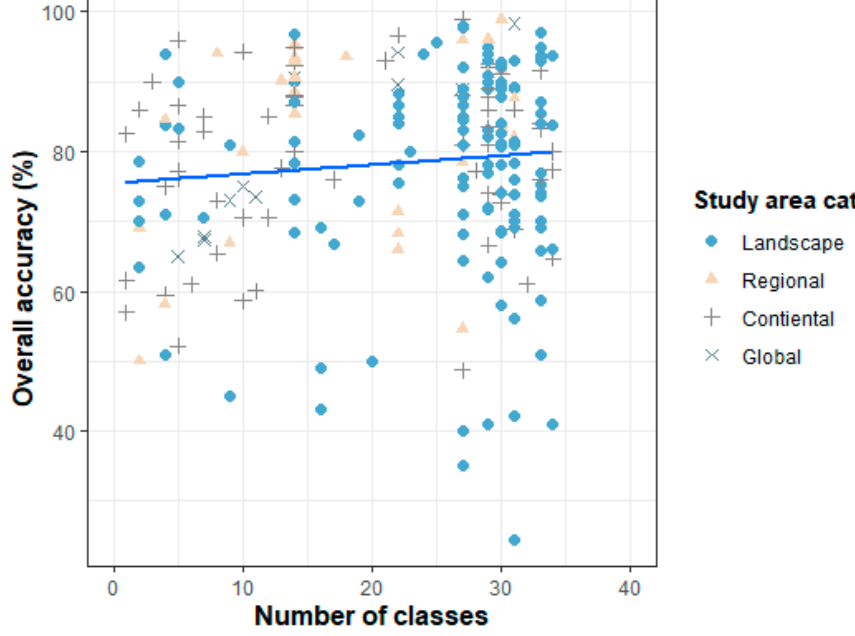
Figure 5. Relationship between the number of classes and the overall classification accuracy (for clarity the number of classes is limited to 40).